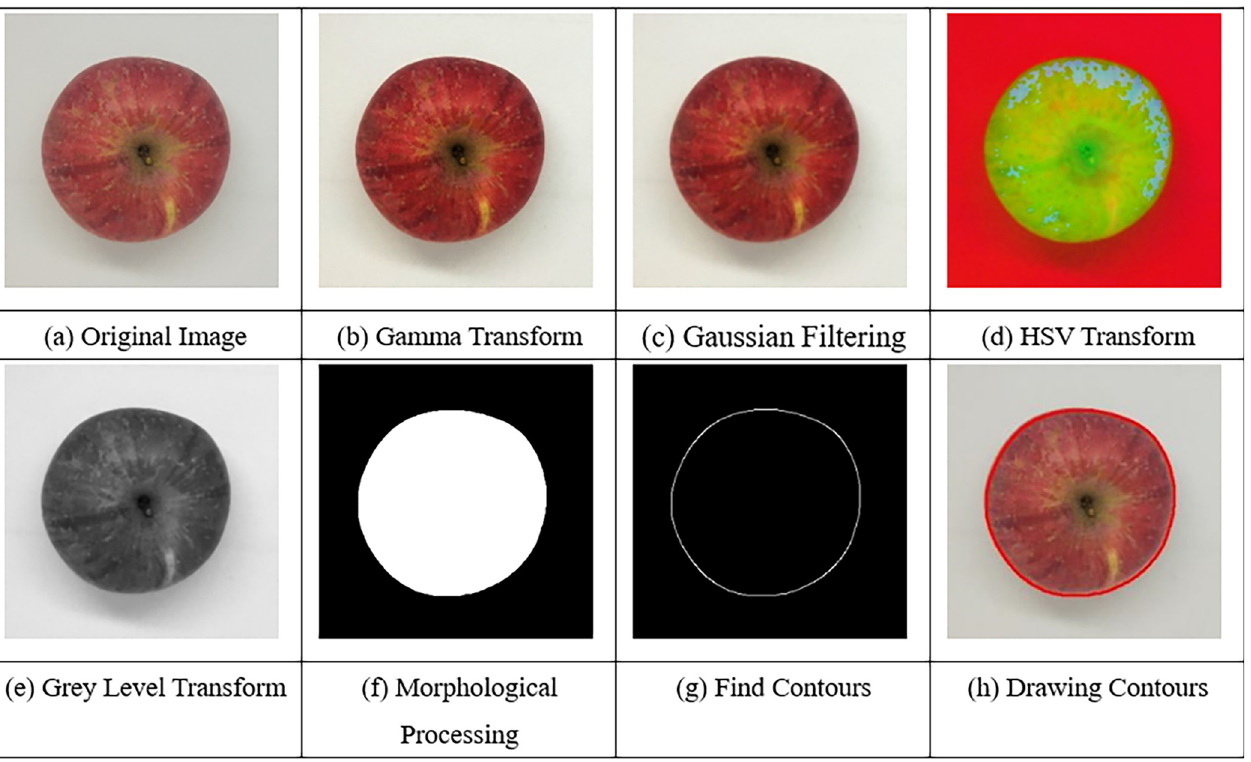
Fig 4. Image preprocessing process. (a) Original image (b) Gamma transform (c) Gaussian filtering (d) HSV transform (e) Grey level transform (f) Morphological processing (g) Find contours (h) Drawing contours.